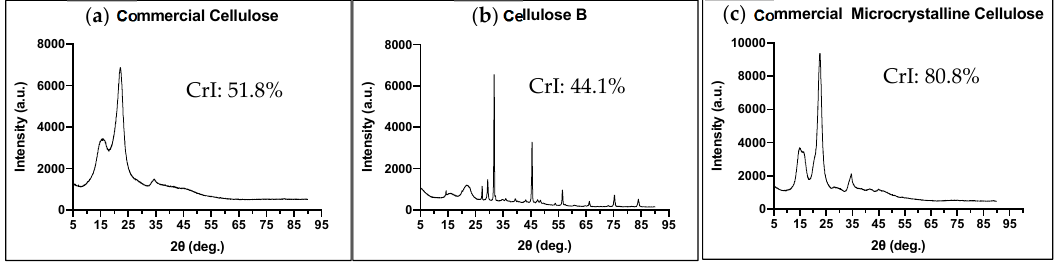
Figure 1. X-ray diffraction and crystallinity index (CrI) for powders of the three excipients. ( a ) commercial cellulose (CC); ( b ) borojó cellulose (BC); ( c ) commercial microcrystalline cellulose (CMCC).